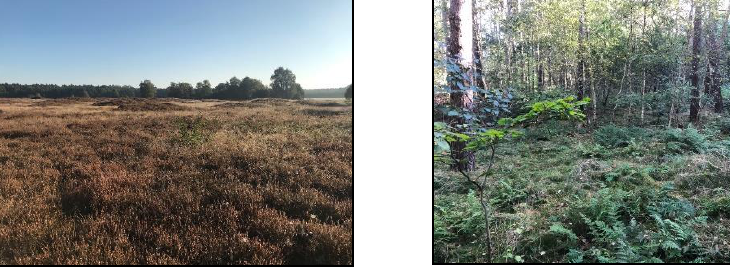
Figure 2. Open land plot ( left ), canopy drip plot ( center ) and tree layer cover ( right ) at site NI116. Photos: S. Nickel.